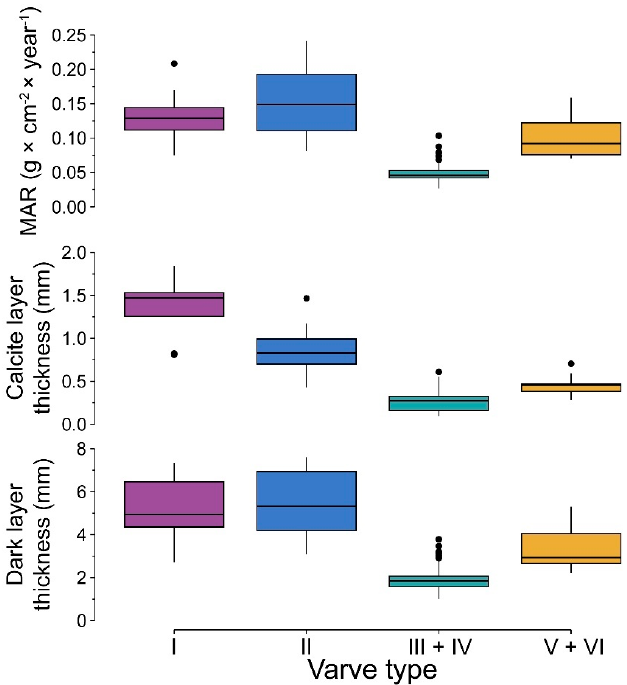
Figure 4. Boxplots of sedimentological properties aggregated for varve types I–VI. Boxplot hinges represent the 25th and 75th quantiles, solid horizontal line represents the mean, notches indicate maximum and minimum values within the 1.5 inter-quartile range and black dots represent outliers.